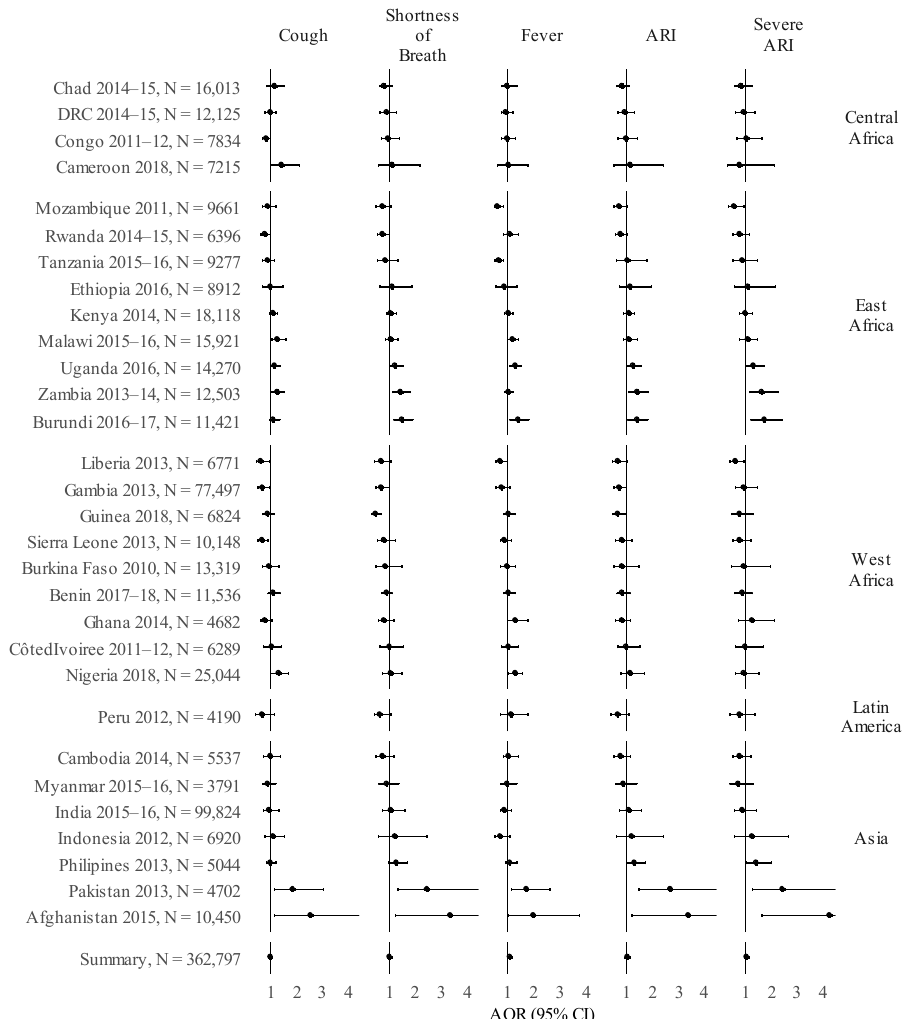
Figure 2. Forest plot illustrating the adjusted odds ratio (AOR) for respiratory symptoms, ARI and severe ARI with wood cooking fuel compared to charcoal for all countries. The summary measure is adjusted for: age, birth order, mode of delivery, vitamin A supplementation, mother’s age, mother’s education level, wealth status, number of household members, rural/urban residence and location of cooking.